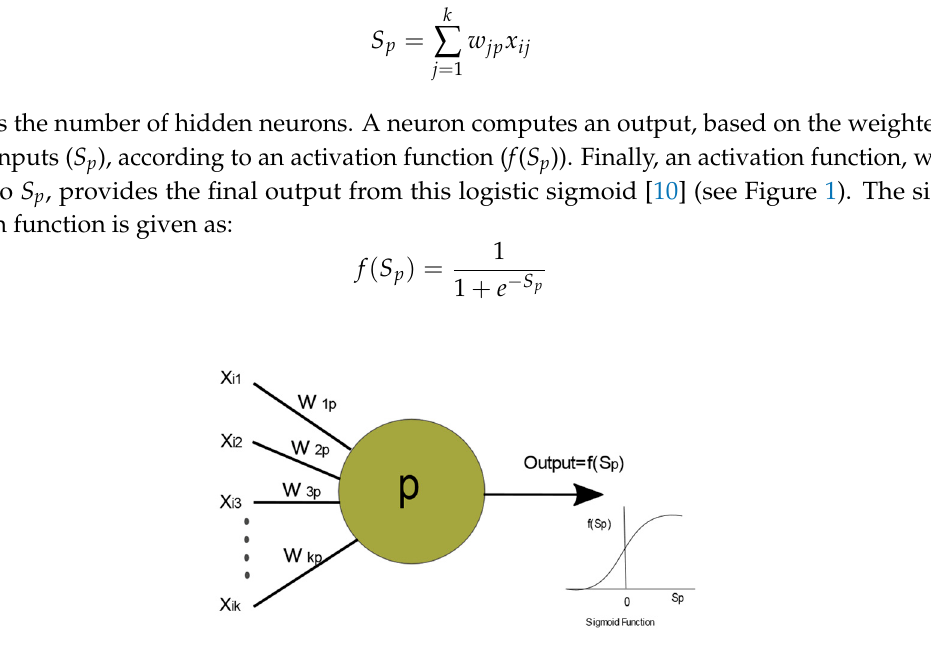
Figure 1. Activation of a single neuron.